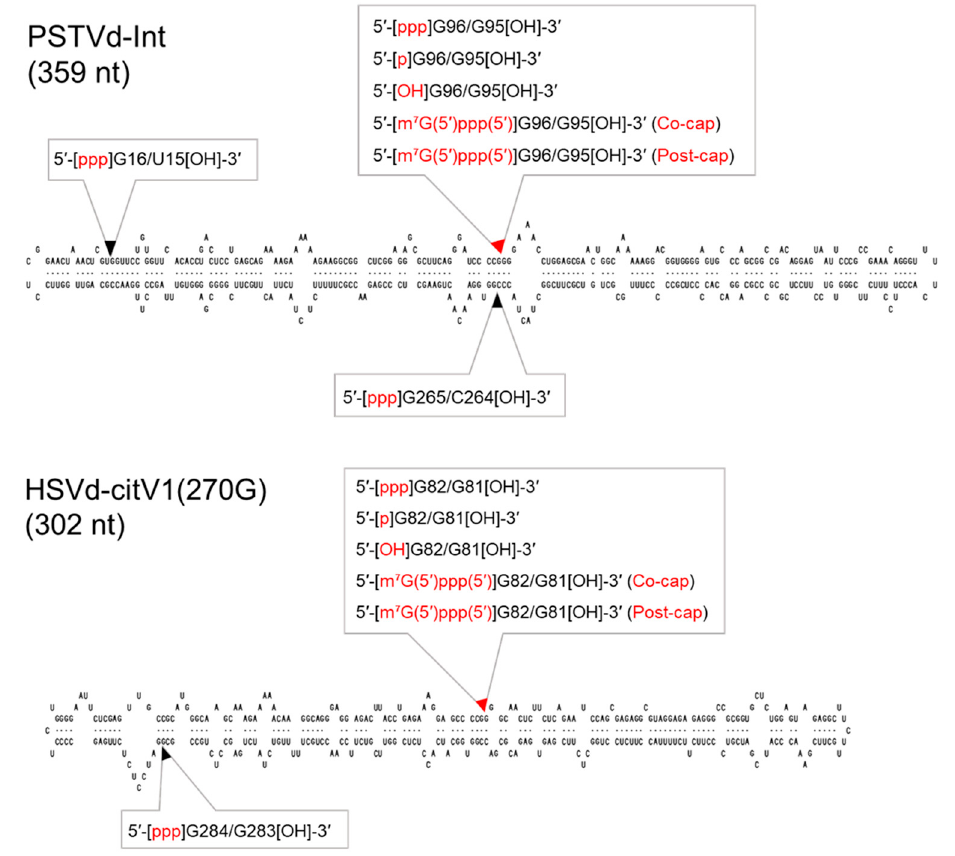
Figure 2. Transcription initiation sites and 5 (cid:48) -terminus modifications in viroid sequences to synthesize complete monomeric RNA transcripts. The constructions of monomeric viroid cDNA clones of potato spindle tuber viroid (PSTVd) and hop stunt viroid (HSVd) are described in Figure 1. Each arrowhead indicates a dividing position into a transcription initiation and termination site. Each red arrowhead indicates the putative processing/ligation site in the viroid replication process. [ppp]: triphosphate; [p]: monophosphate; [OH]: hydroxyl; [m 7 G(5 (cid:48) )ppp(5 (cid:48) )]: cap; Co-cap: co-transcriptional capping; post-cap: post-transcriptional